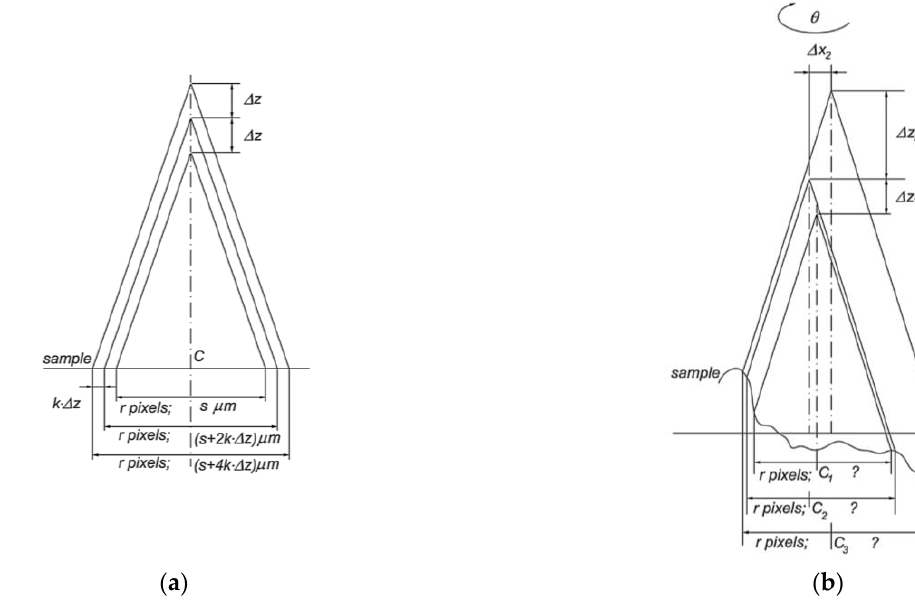
Figure 4. The central projection of a large sample—ideal case ( a ) can be solved by elementary mathematics, real case ( b ) necessitates sophisticated mathematical tools. Taken from [26].